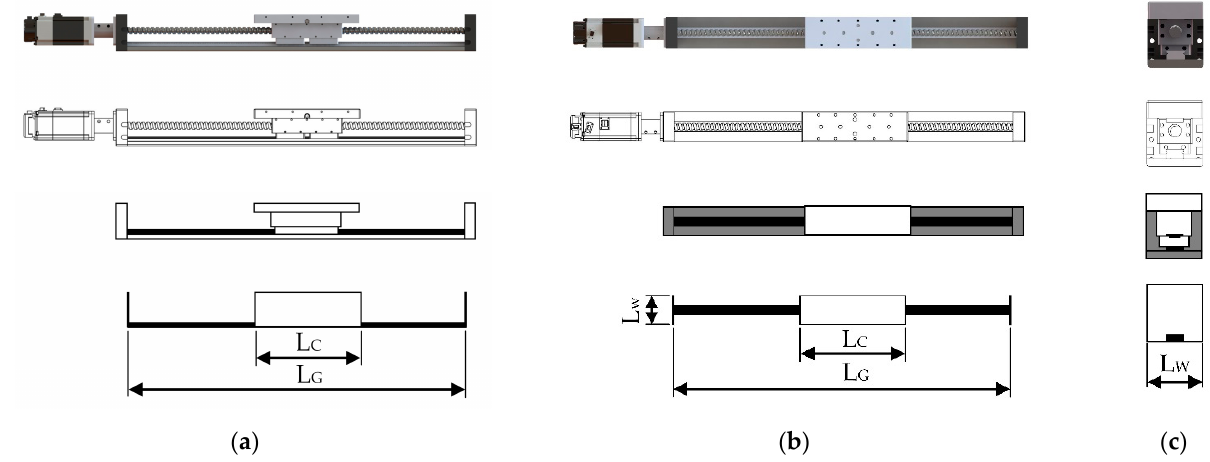
Figure 6. Stages of MMCS simplification of a linear servo axis with ball screw. ( a ) Lateral view; ( b ) top view; ( c ) side view.